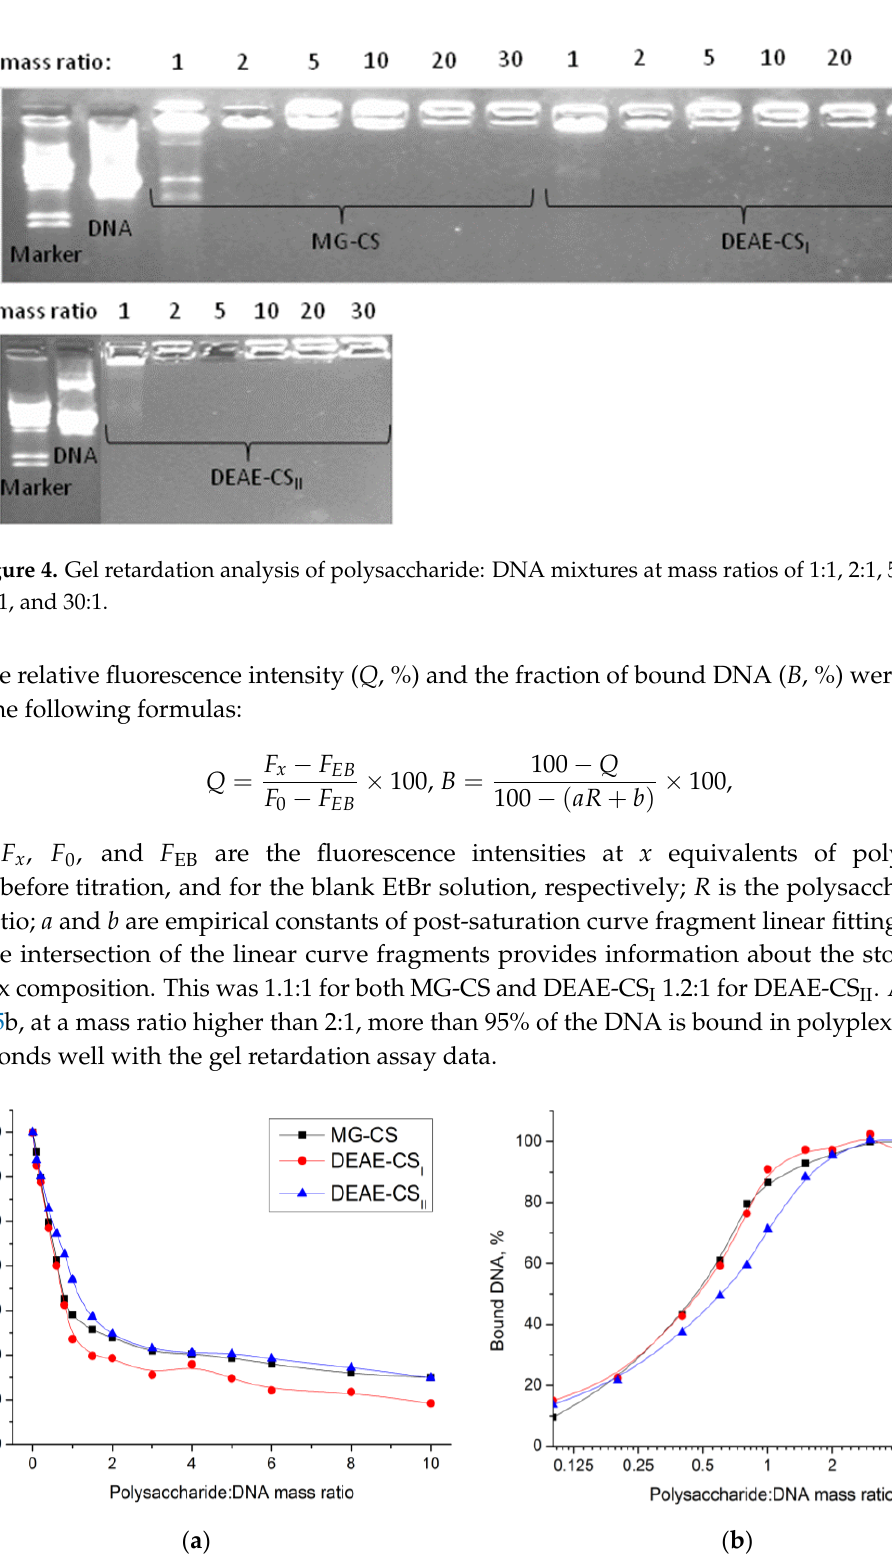
Figure 3. Cell viability after 24 h of incubation with chitosan derivatives. Values are the mean ± standard deviation; measurements were performed as 3 individual experiments with 6 technical